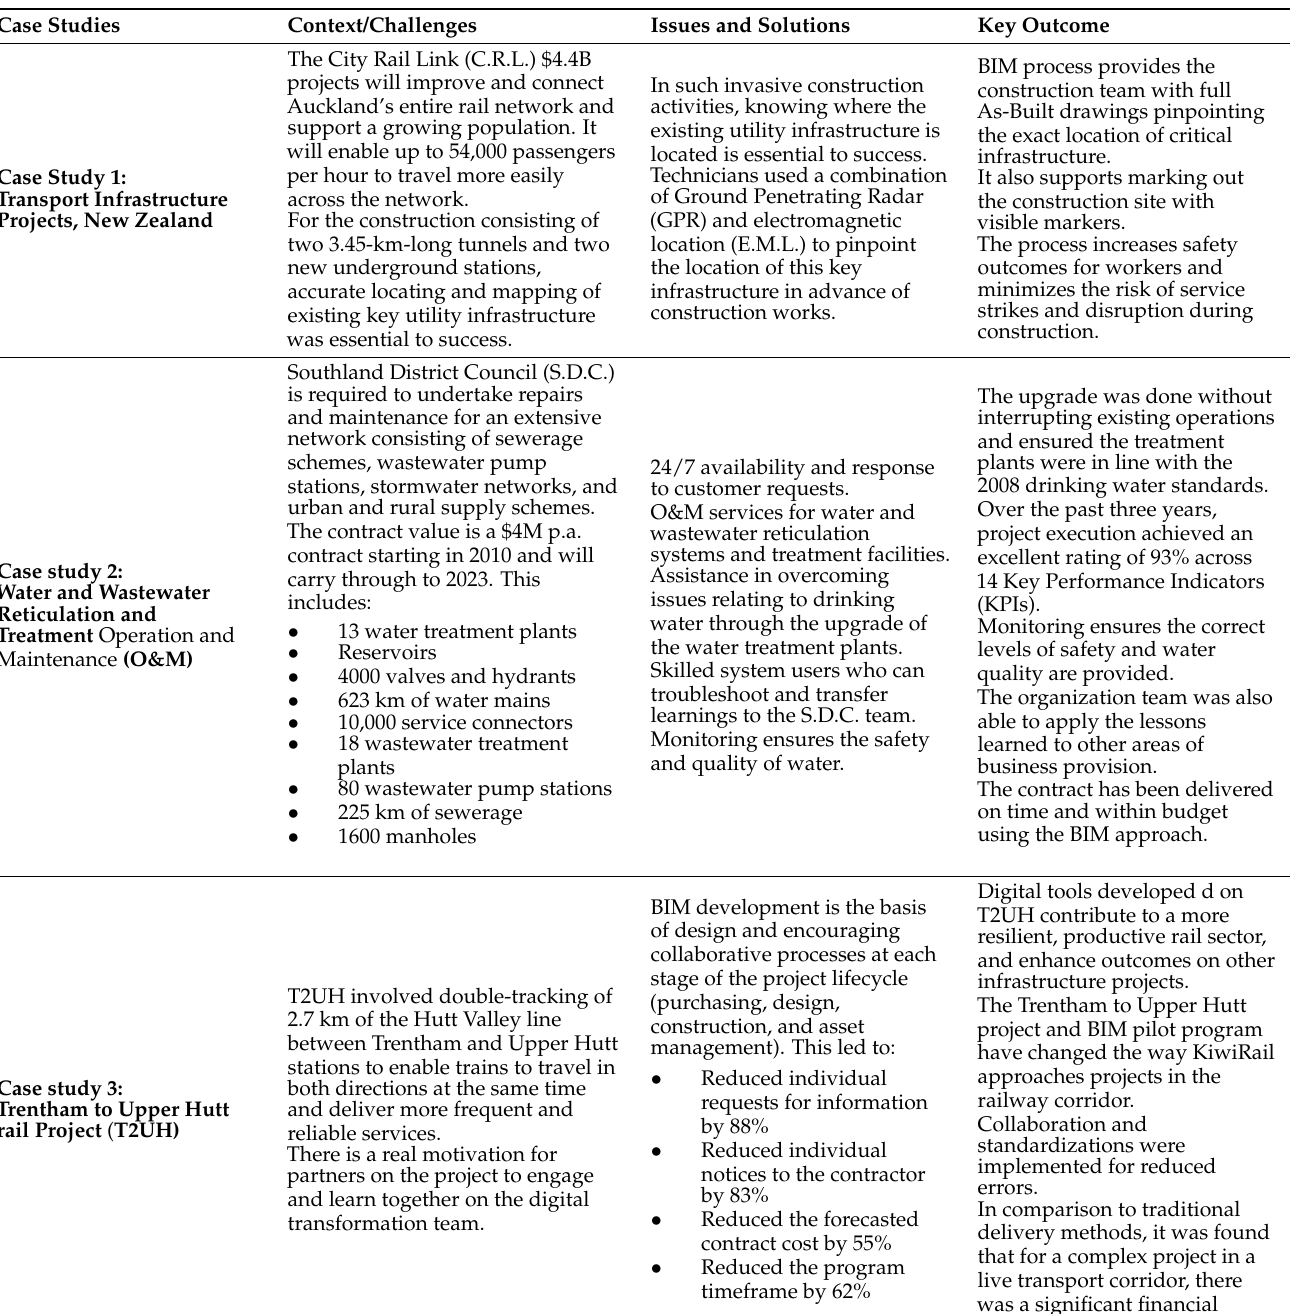
Table 5. Summary of case